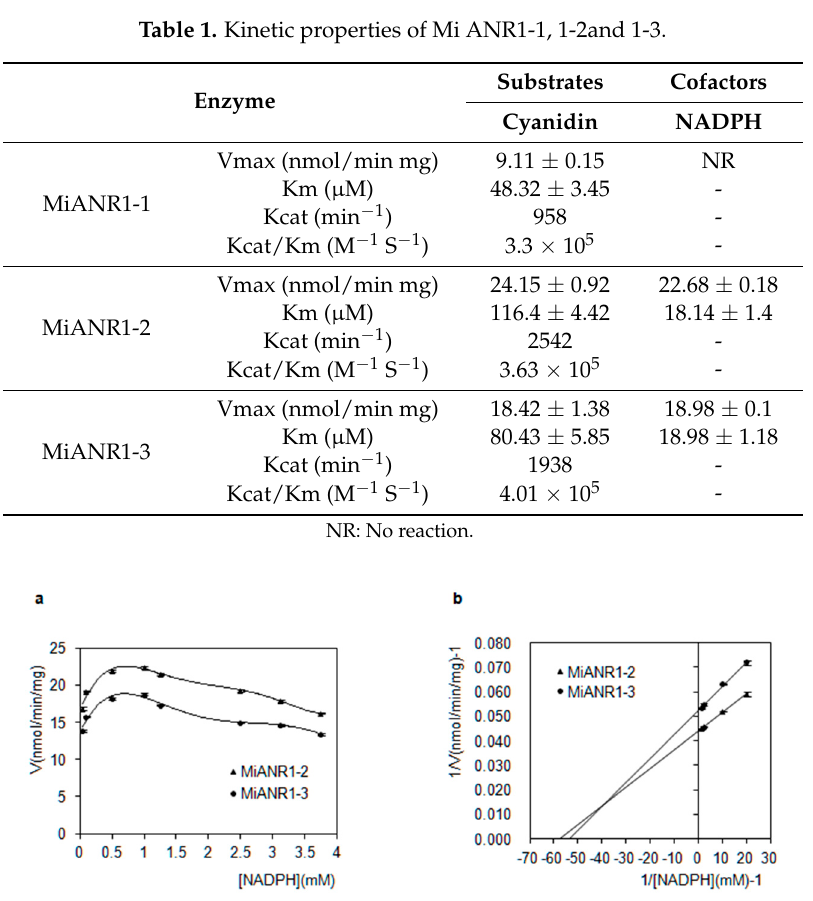
Figure 6. Kinetics of MiANR1-2, and 1-3 to NADPH. The initial velocity was expressed with nanomolar products produced from cyanidin per minute by per milligram of MiANR1-2/1-3 at varying NADPH concentrations. A plot of initial velocity versus [NADPH] for MiANR1-2/1-3 ( a ) and a double-reciprocal plot of 1/V versus 1/[NADPH]for MiANR1-2/1-3 ( b ).